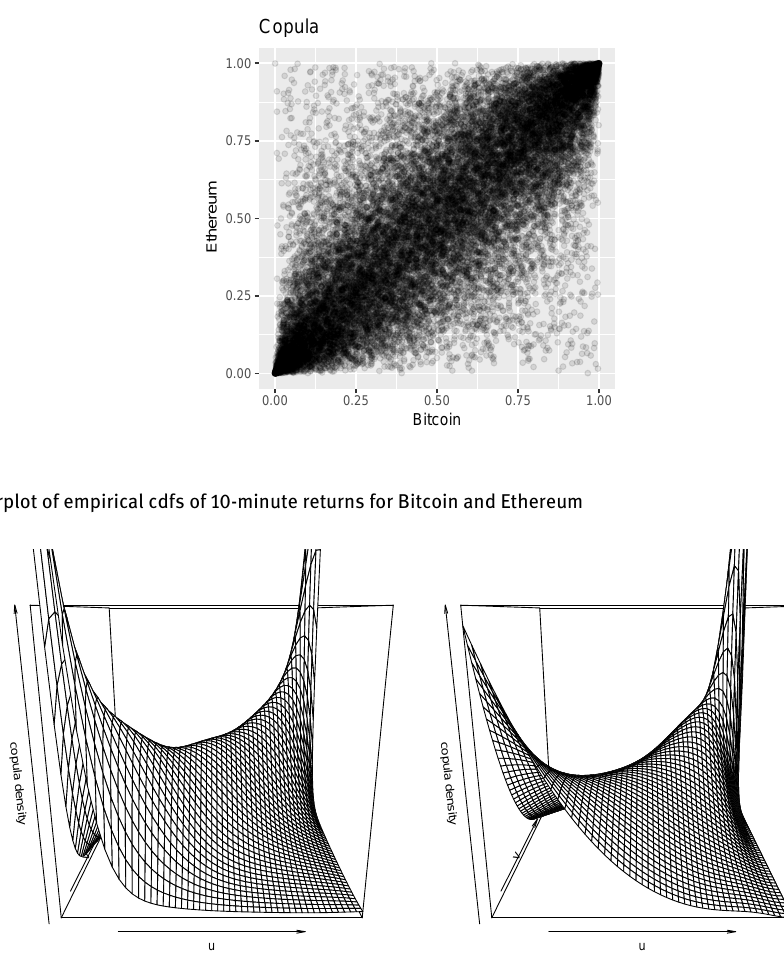
Figure 9: Estimated copula densities of high-frequency Bitcoin and Ethereum returns for binomial (left) and negative binomial (right) generators, the scales are the same in both